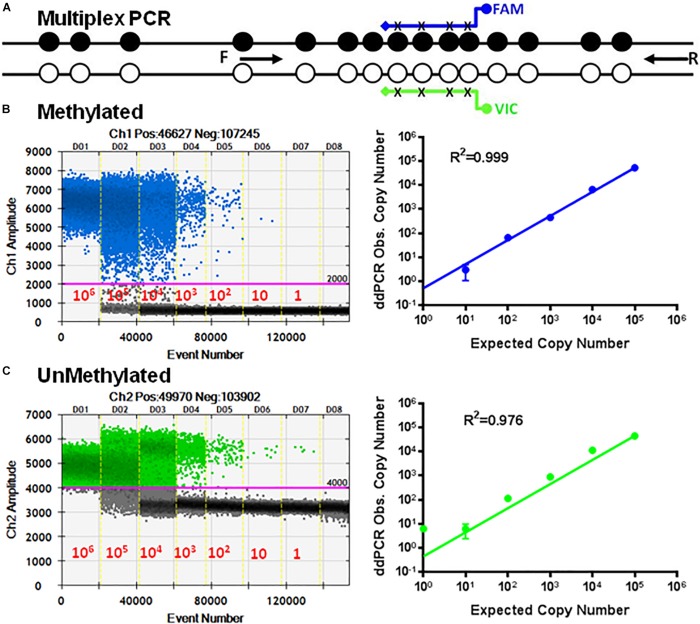
Multiplex ddMSP assay. (A) Schematic illustration of the TSDR of FOXP3 showing two general TSDR primers with probes for each of the methylated and unmethylated CpGs that interrogates four CpGs of TSDR. Standard curves of methylated (B) and unmethylated (C) FOXP3 TSDR in the same reaction. ddPCR using serially diluted mixed plasmids (106–1 copy/reaction). Standard curves with linear regression analysis for methylated and unmethylated targets. The data shown are the average with standard deviation (SD) of three repeats.